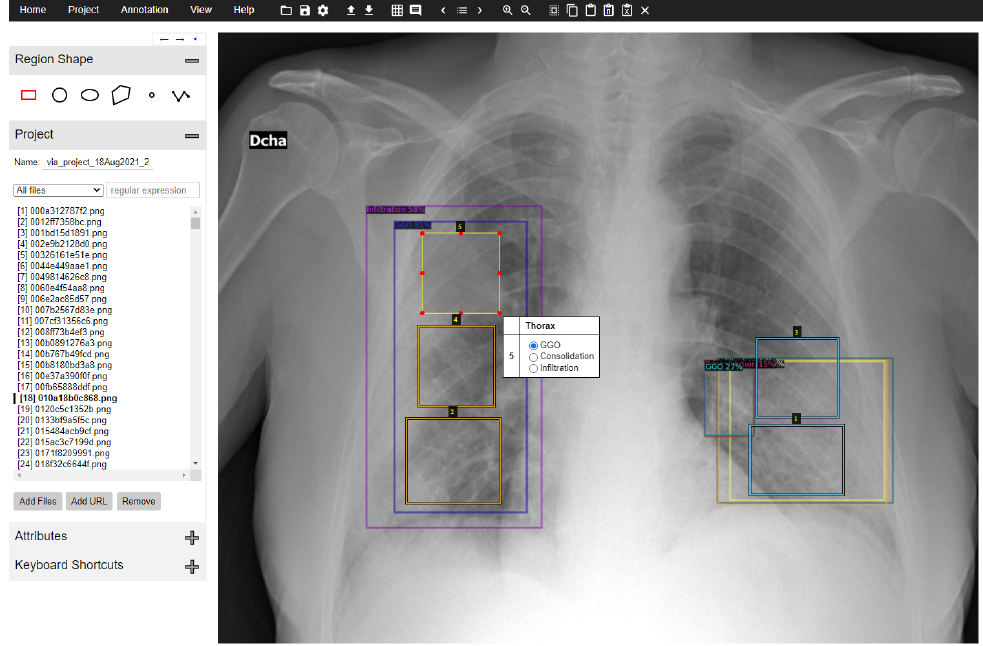
Figure 5. Open-source VIA tool employed to annotate and standardize the dataset into COCO